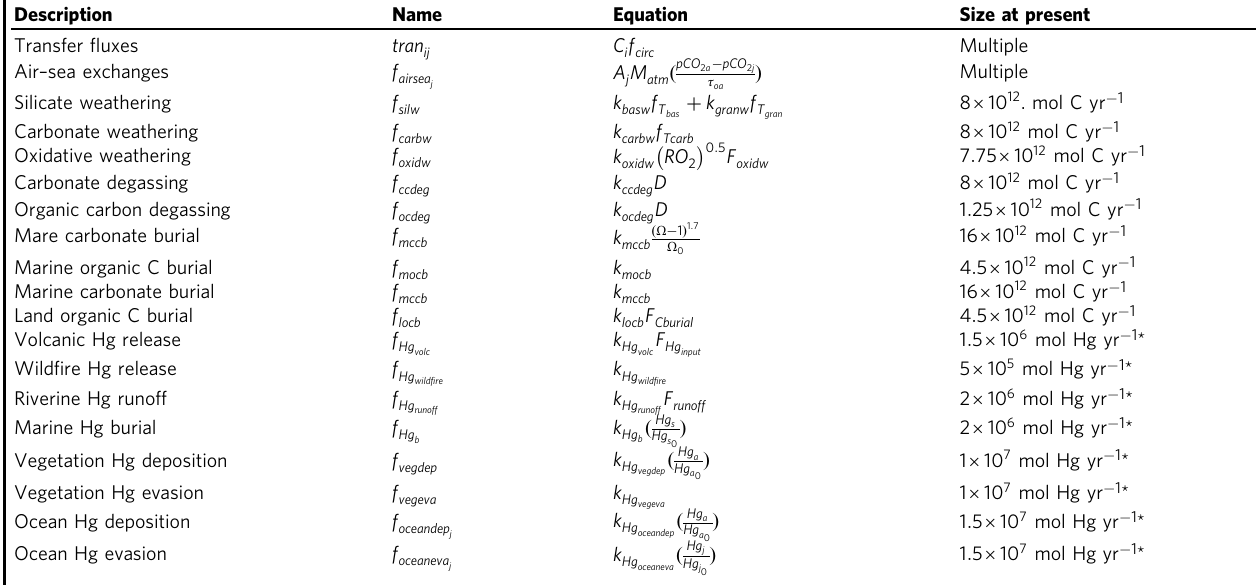
Table 2 Model fl uxes.